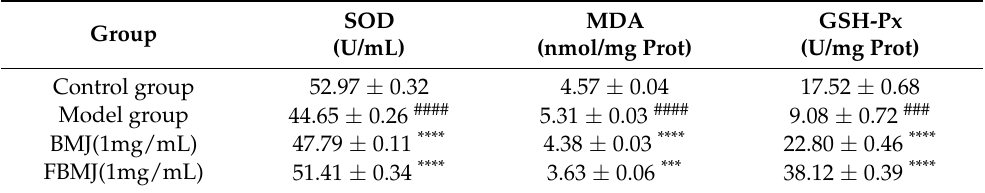
Table 7. Effects of FBMJ on SOD activity, GSH-PX activity, and MDA content in C2C12 cells.